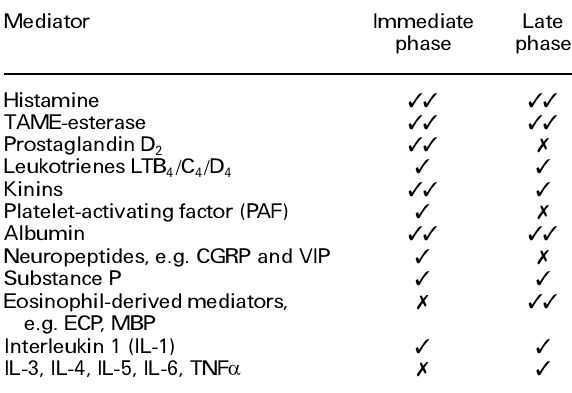
Table 1. Mediators found in nasal lavage fluid collected following both the immediate and late phase response in atopic individuals challenged intranasally with allergen 4